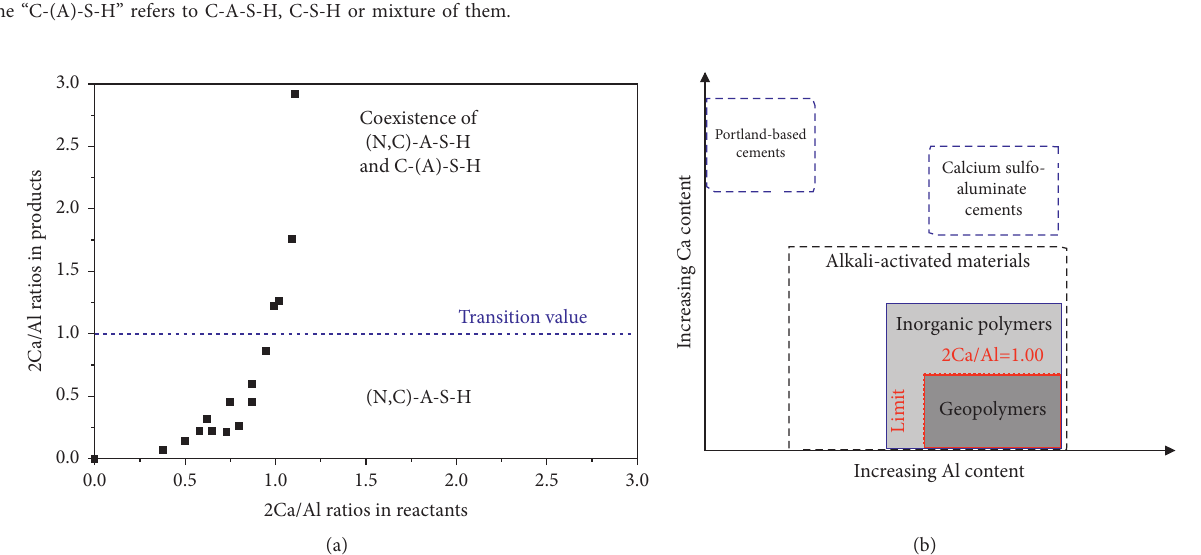
Figure 1: (a) Verification of gel products by 2Ca/Al ratios in products and (b) quantitative boundary of geopolymer